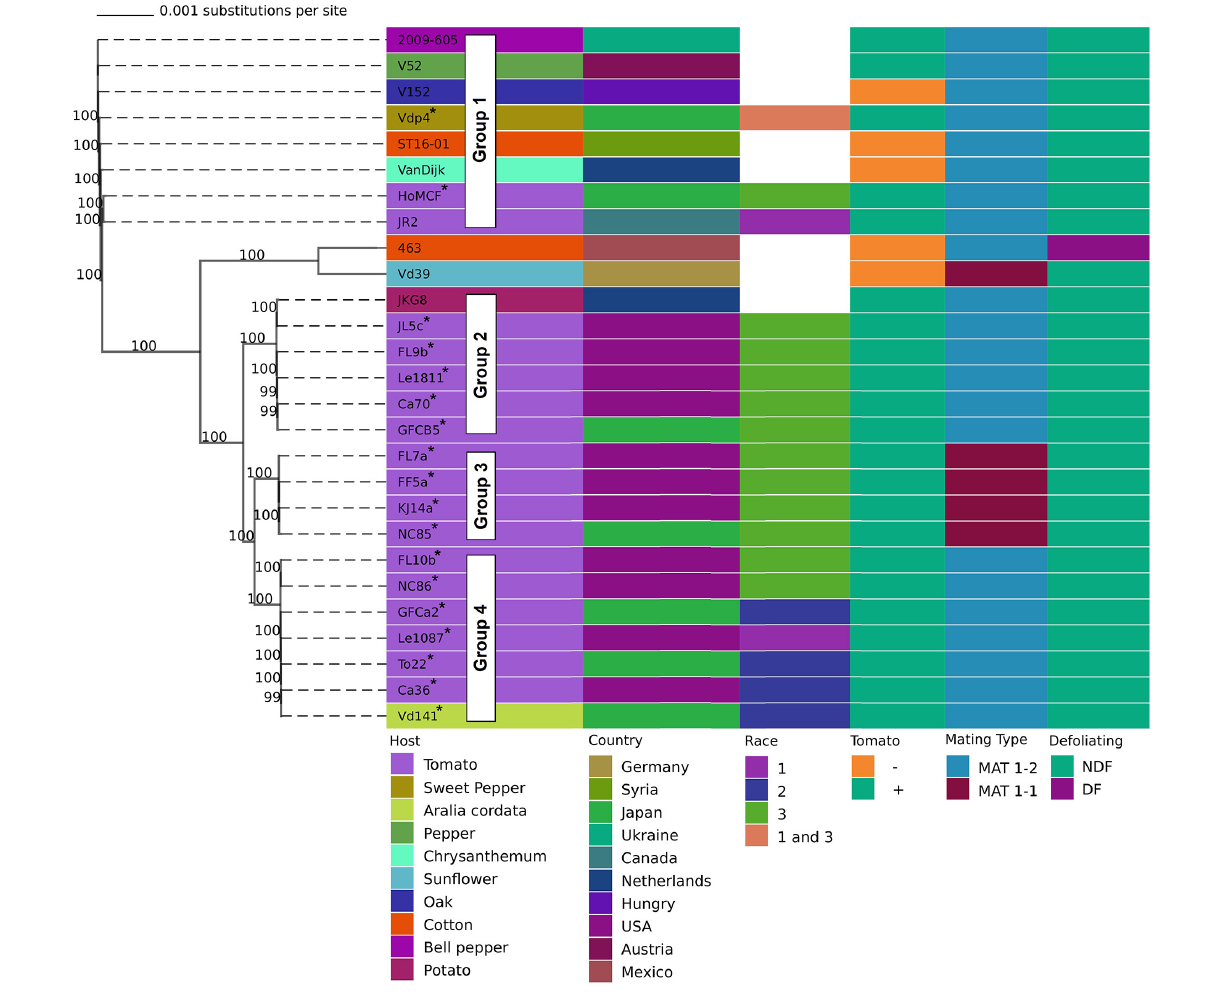
FIGURE 1 | Phylogenetic tree developed from whole genome alignment of V. dahliae isolates from multiple hosts, countries, and mating types. Bootstrap values determined using 1000 replications. Isolates marked with * were sequenced for this study. Pathogenicity on tomato confirmed using universally susceptible tomato lines. Four phylogenetically distinct groups among isolates infecting tomato are